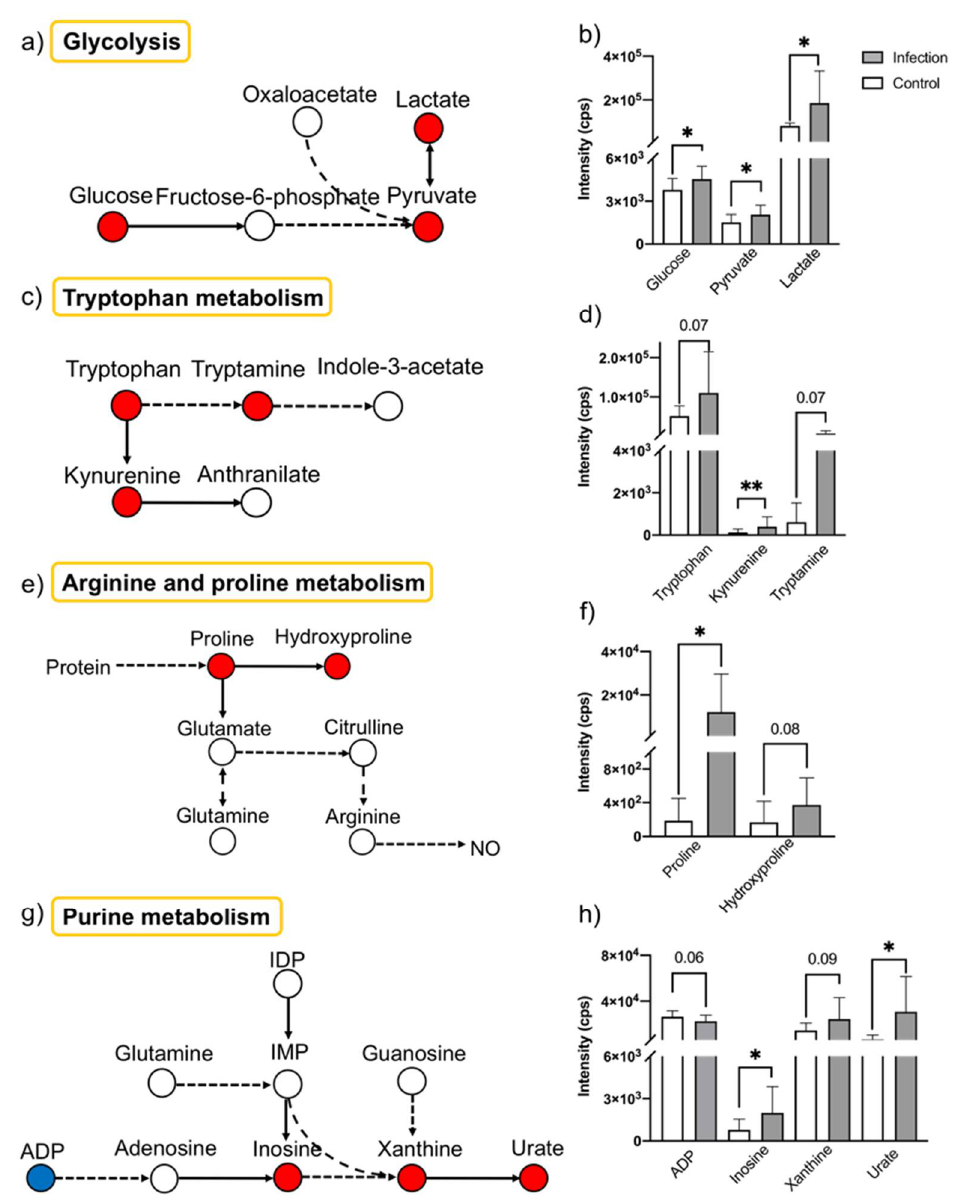
Figure 4. Overview of the metabolic dysregulation in glycolysis ( a ), tryptophan metabolism ( c ), arginine and proline metabolism ( e ), and purine metabolism pathways ( g ), up-regulated, stable, and down-regulated metabolites are marked in red, white, and blue, respectively; solid and dotted lines indicate direct and indirect reactions, respectively; significant intensity differences between infection and control cohorts verified by targeted metabolomic analysis ( b , d , f , h ), error bars represent the standard deviation, and “*” and “**” represent p values less than 0.05 and 0.01, respectively.